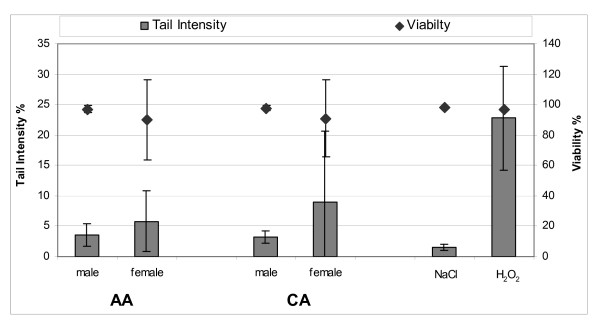
DNA damage and viability of HT 29 cells after incubation with FW. AAs (n = 21), CAs (n = 22), males and females. NaCl -- negative control; H2O2 -- positive control.